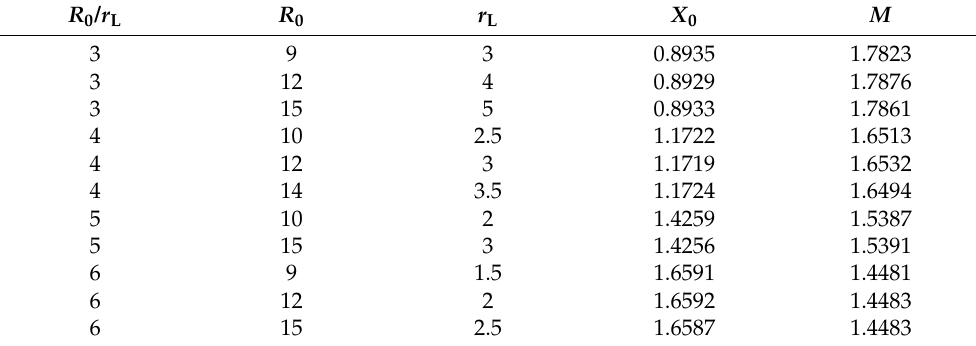
Table 1. Fitting results for X 0 and M